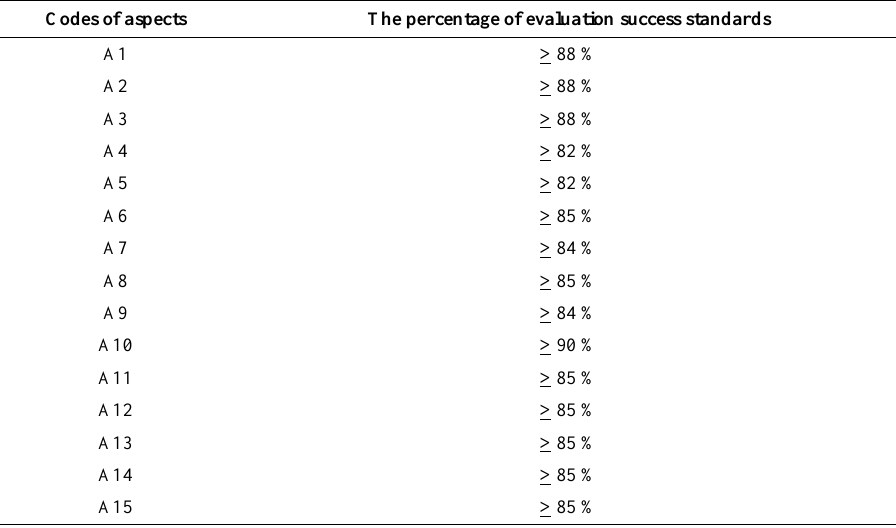
Table 2. Percentage of success standards for evaluating the blended learning implementation at IT vocational schools in